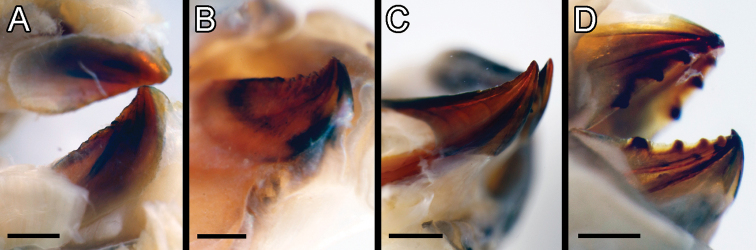
Micrographs of Peinaleopolynoe spp. jaws APeinaleopolynoe
orphanae sp. nov. paratype SIO-BIC A9996 BPeinaleopolynoe
elvisi sp. nov. holotype SIO-BIC A8488 CPeinaleopolynoe
goffrediae sp. nov. holotype SIO-BIC A5485 DPeinaleopolynoe
mineoi sp. nov. paratype SIO-BIC A9709. Scale bars: 3 mm (A, C); 2 mm (B, D).